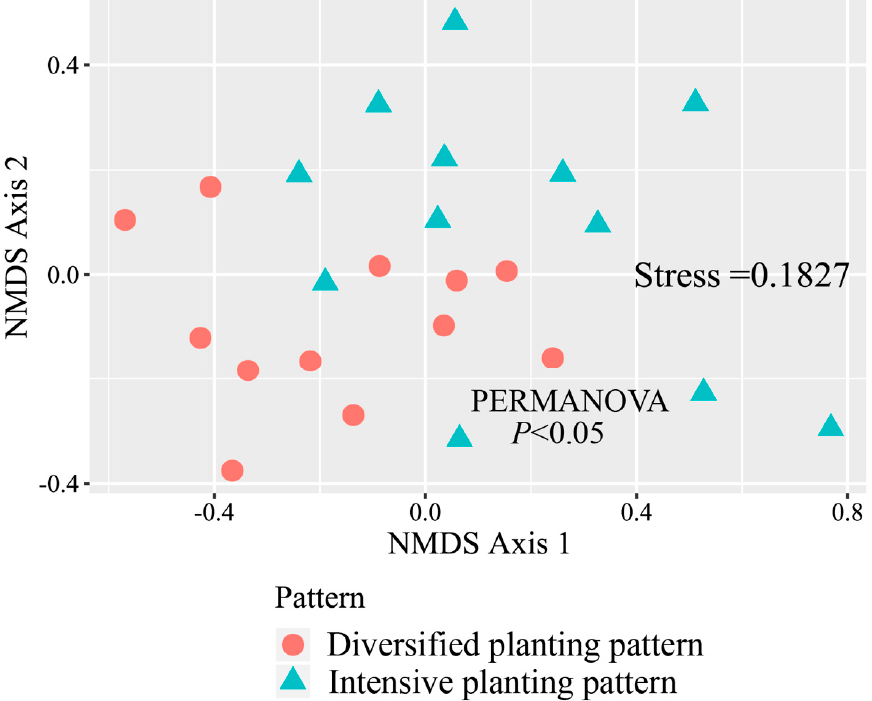
Figure 3. The non-metric multidimensional scaling (NMDS) of community dissimilarity (Bray–Curtis) showing differences in the community compositions of vegetation-dwelling arthropods in naked oat fields under different planting patterns.